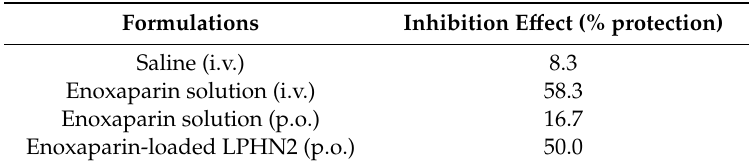
Table 3. Inhibition e ff ect of pulmonary thromboembolism by orally administered various enoxaparin formulations ( n =